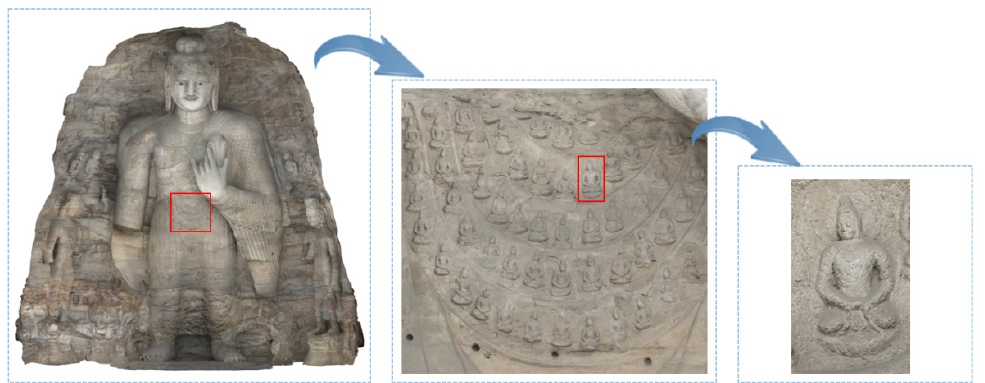
Figure 1. Small statues carved onto the statues in the 18th cave of the Yungang Grottoes, China.